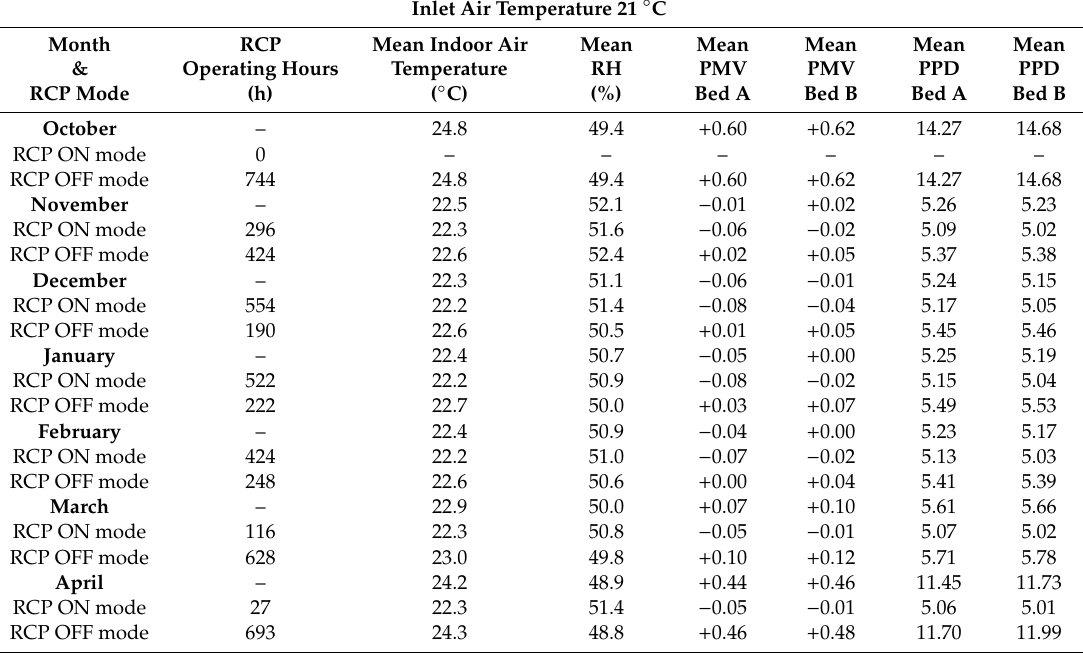
Table 6. Monthly RCP operating hours, mean indoor air temperature, RH, PMV and PPD with inlet air temperature of 21 ◦ C.